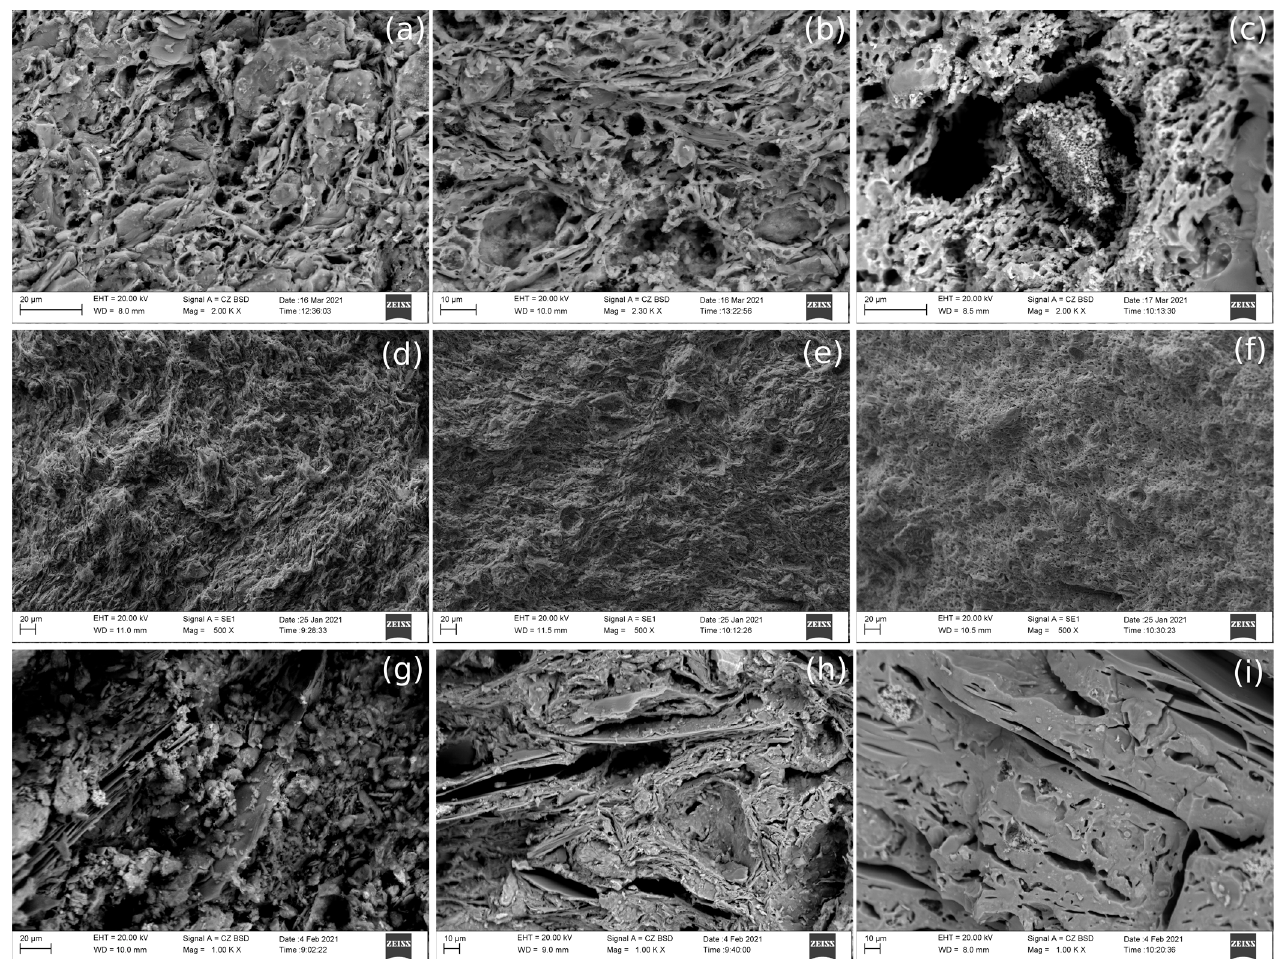
Figure 5. SEM-BSD image of the fractured surfaces of PT, PF and AP control-pieces. ( a–c ) PT-01, PT-05, PT-09; ( d–f ) PF-01, PF-05, PF-09; ( g–i ) AP-01, AP-05, AP-09.